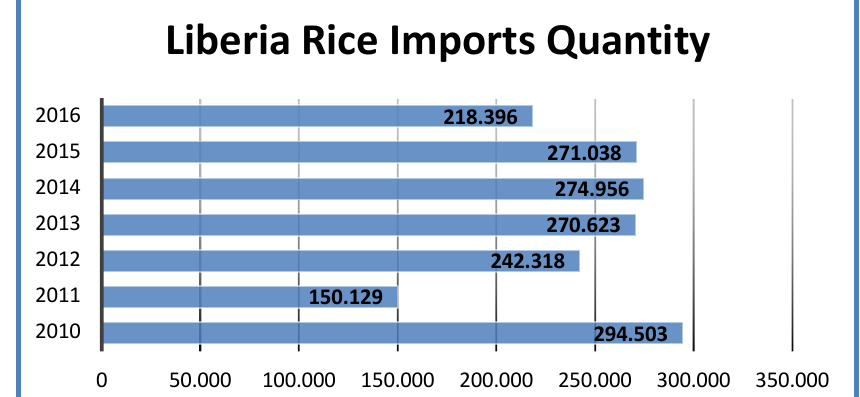
Figure 8: Liberia rice Import in tons (Liberia-Rice imports quantity,